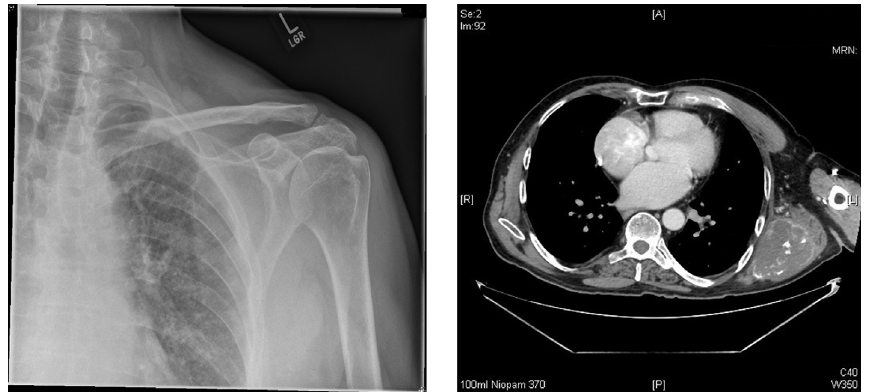
Figure 3. Plain radiograph of left shoulder girdle only showing some soft tissue swelling around the lateral border of the scapula whereas the CT scan demonstrates a destructive lesion consistent with chondrosarcoma.